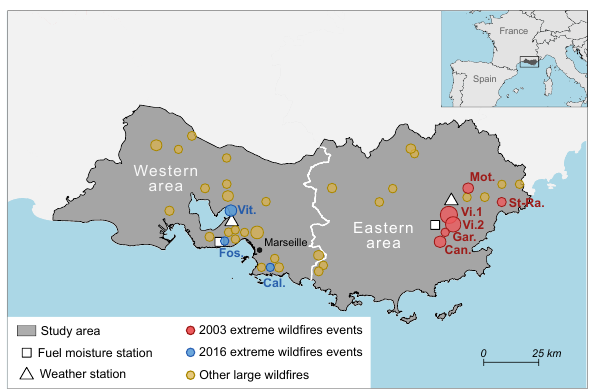
Figure 1. Map of the study area in southern France showing (i) the location of summer large wildfires ( > 250ha) classified into three groups, (ii) the boundary of the areas delineating different climatic patterns and (iii) the location of weather and fuel moisture stations. The size of fire points is proportional to the size of the correspond- ing fire (min = 250ha; max = 5646ha). An individual description of the 2003 and 2016 extreme wildfires events can be found in Ta- ble 1.